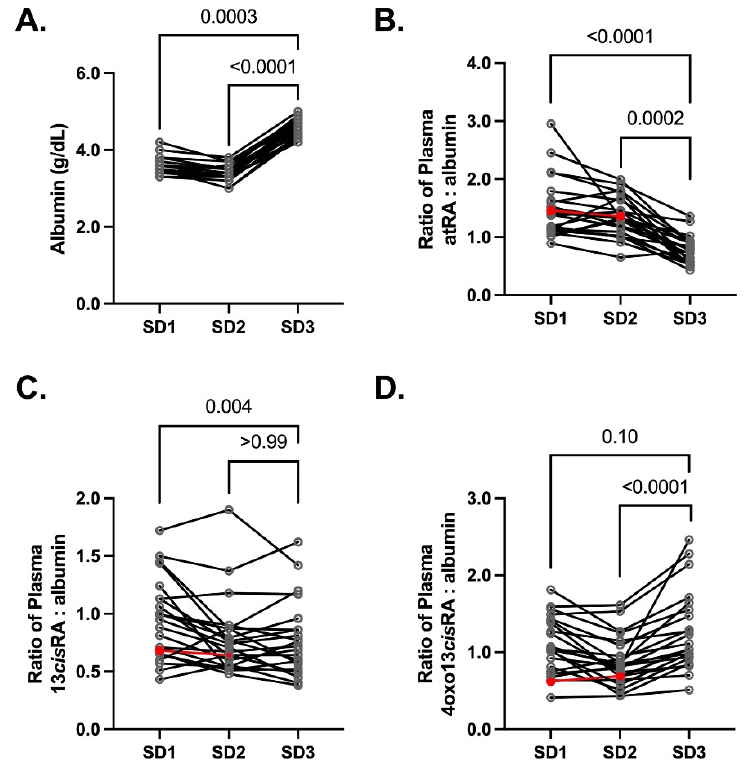
Figure 4. Plasma ( A ) albumin was measured on each study visit during 25–28 weeks gestation (SD1), 28–32 weeks gestation (SD2), and 3–4 months PP (SD3). Plasma retinoid concentrations were normalized to the albumin concentration and shown as a ratio in ( B – D ). In panels B – D , one subject was excluded for statistical comparisons due insufficient sample for SD3 retinoid concentrations (red symbols) ( n = 22 pregnant women).